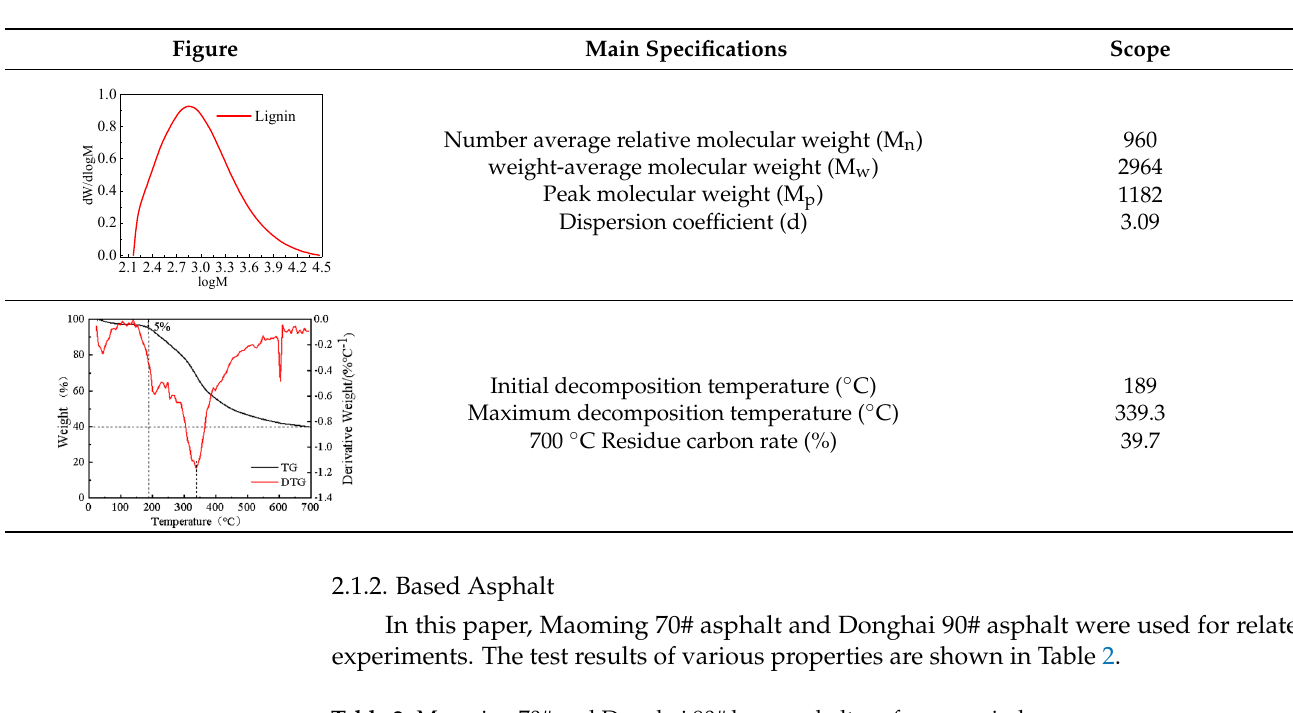
Table 2. Maoming 70# and Donghai 90# base asphalt performance indexes.